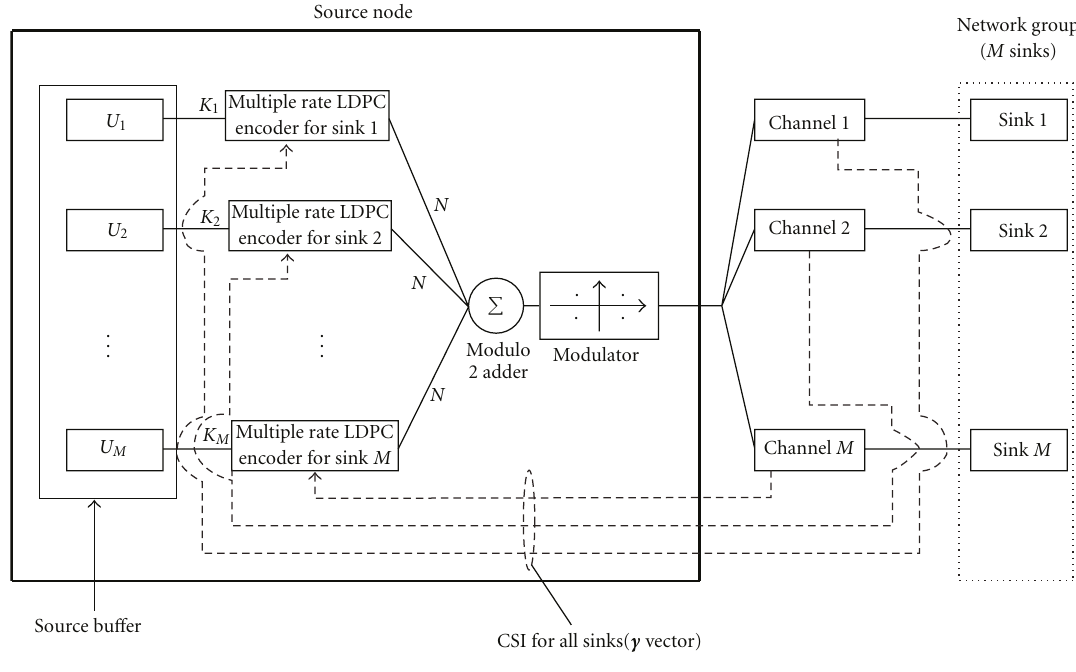
Figure 3: Transmission scheme at source node for the proposed adaptive transmission scheme: the number of information symbols per packet addressed to a given sink is adapted to the sink’s channel status using channel encoders at di ff erent rates. In the picture, the packet length at the output of the various blocks is